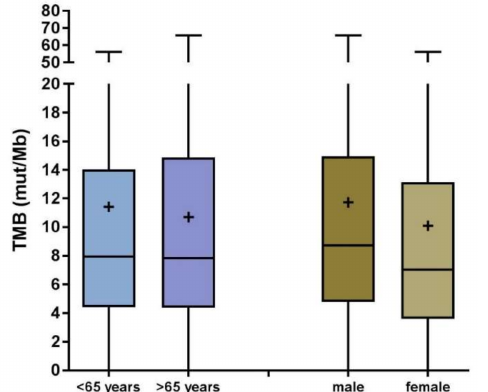
Figure 3. TMB status (mut / Mb) is not significantly correlated to age or gender. Boxplots are shown with the 95% confidence interval indicated by the box. Lines indicate the mean and + the median. Statistical analysis by Student t test did not reveal significant di ff erences in TMB between patients under or over 65 years of age ( p = 0.476), nor between male and female patients ( p = 0.110).